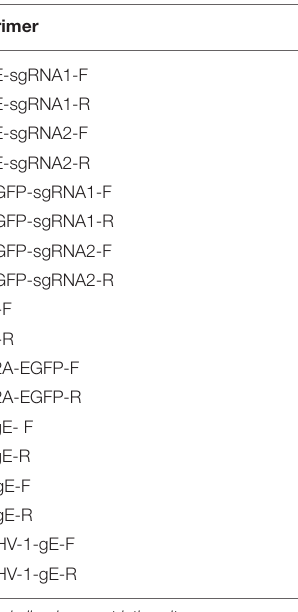
TABLE 1 | Primers used in the